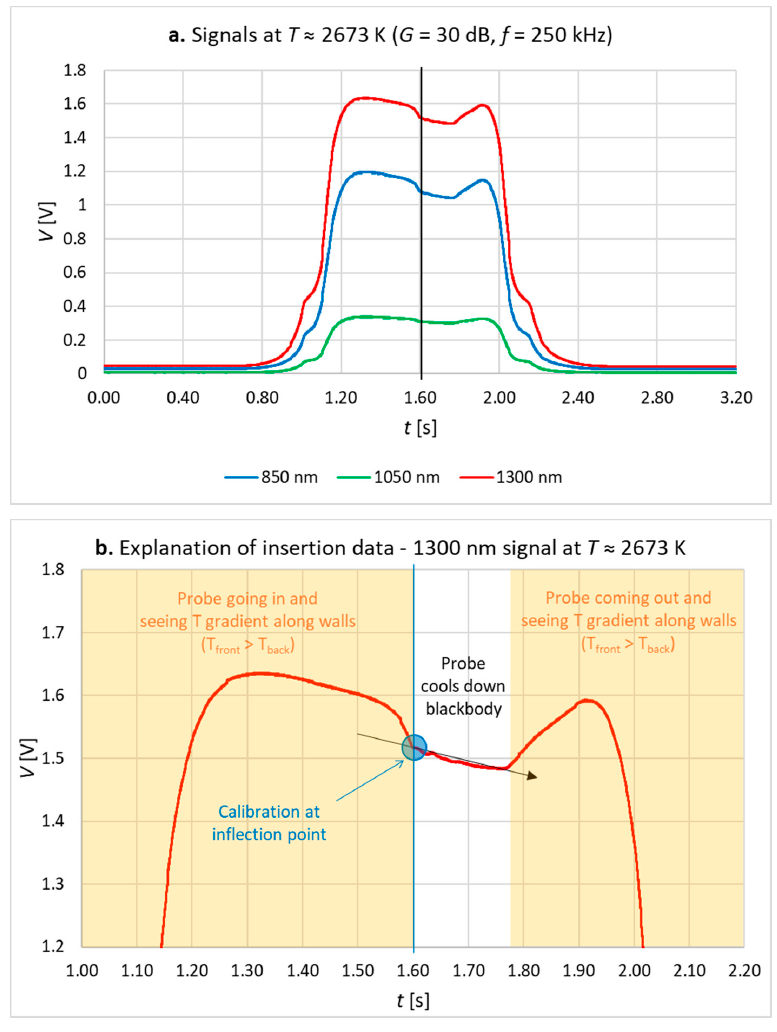
Figure 7. Typical calibration measurement traces: the black line in the middle of chart ( a ) identifies the points used for calibration; ( b ) is a close-up on the 1300 nm signal and its calibration point. Considering Figure 7b: